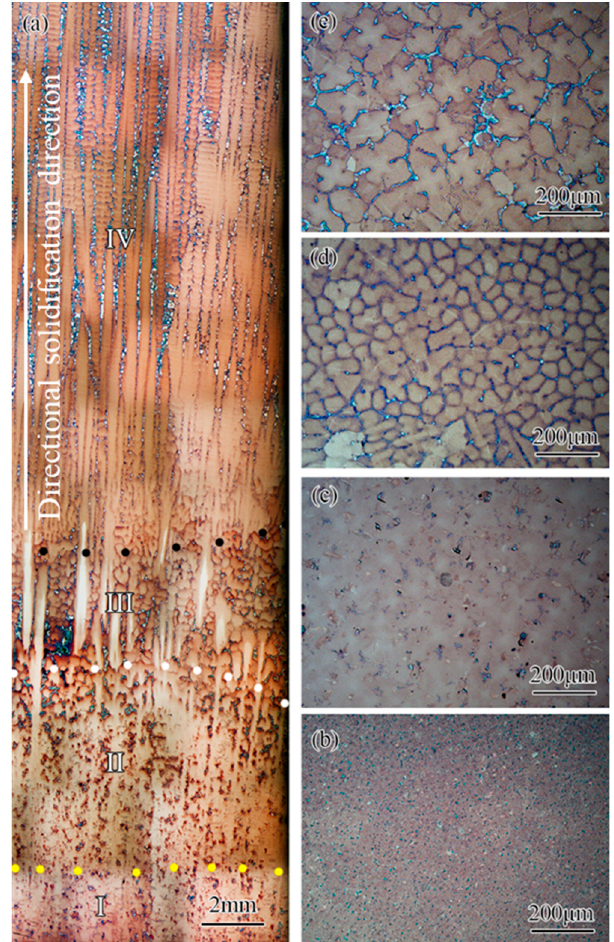
Figure 5. The microstructure of the directional columnar grains after preparing single crystal casting: ( a ) the longitudinal microstructure, and the cross-section microstructures in ( b ) heat-affected zone I; ( c ) mushy zone II; ( d ) transition zone III; ( e ) directional growth zone IV.